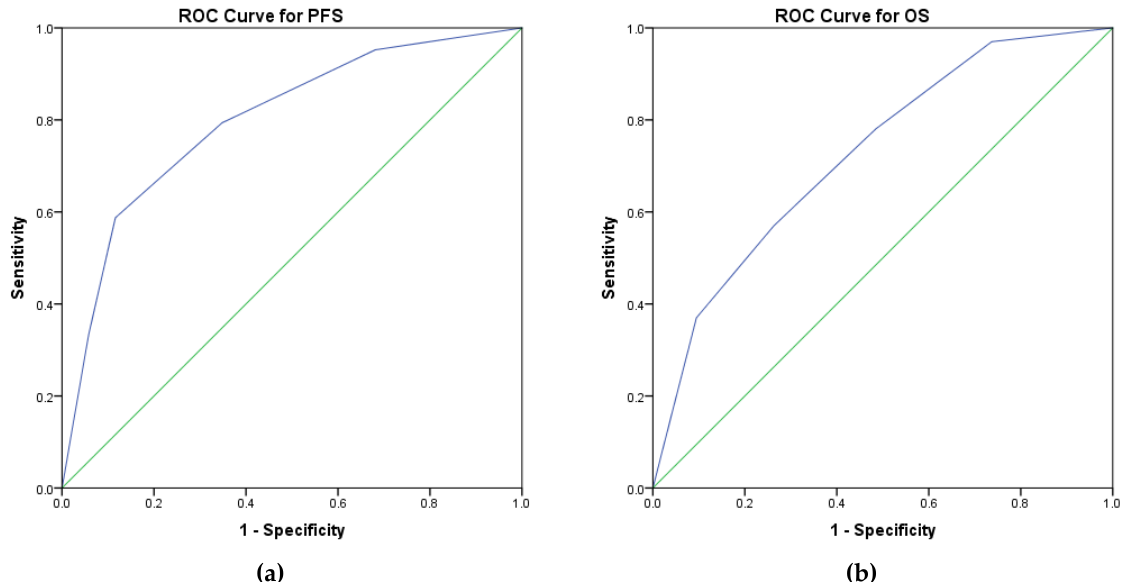
Figure 3. ROC curves estimating the specificity and sensitivity of the prognostic score (( a )-PFS and ( b )-OS).